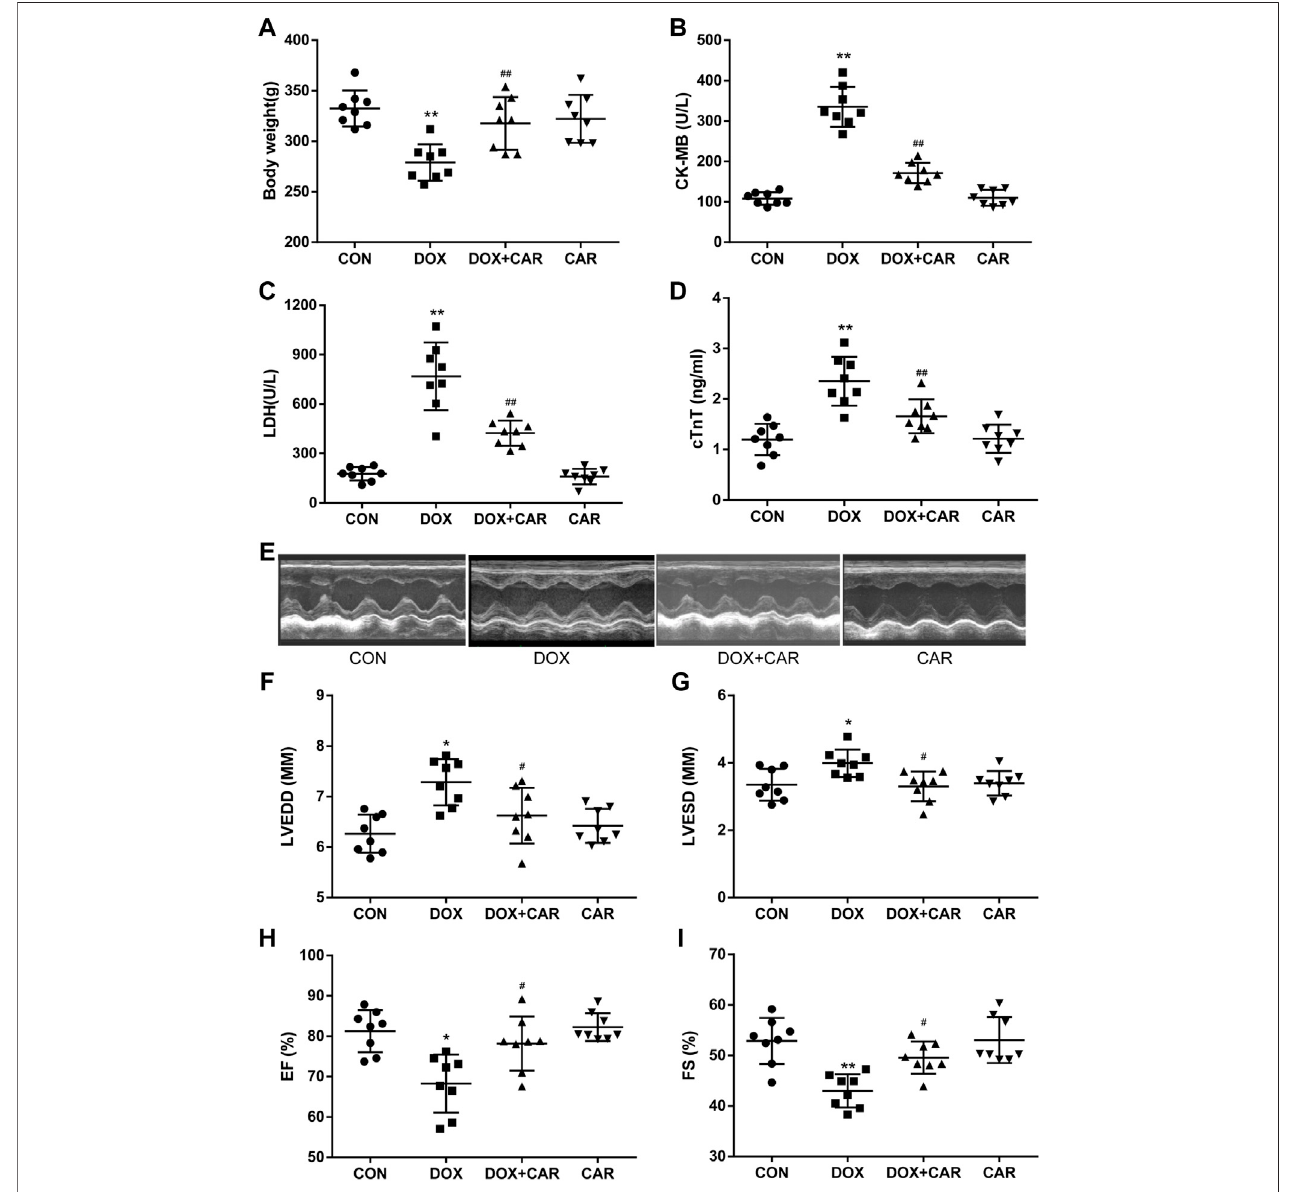
FIGURE 1 | CAR reinstated body weight, myocardial marker enzymes and left ventricular dysfunction in DOX-induced cardiotoxicity in rats. (A) body weight, (B) LDH, (C) CK-MB, (D) cTnT, (E) Representativepicturesofheartfunction, (F) LVEDD, (G) LVESD, (H) EF,and (I) FS.Quantitativedataaremeans±SEM(n=8).One-way ANOVA followed by post hoc Tukey ’ s test. * p < 0.05, ** p < 0.01 vs. CON; # p < 0.05, ## p < 0.01 vs. DOX.